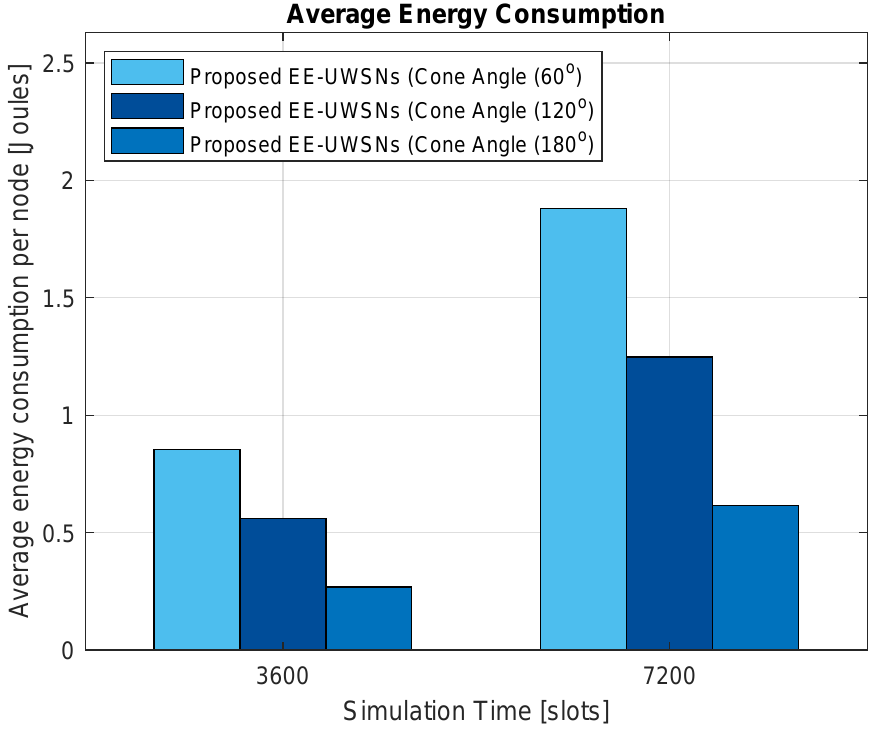
Figure 12. The effect of changing cone angle on energy